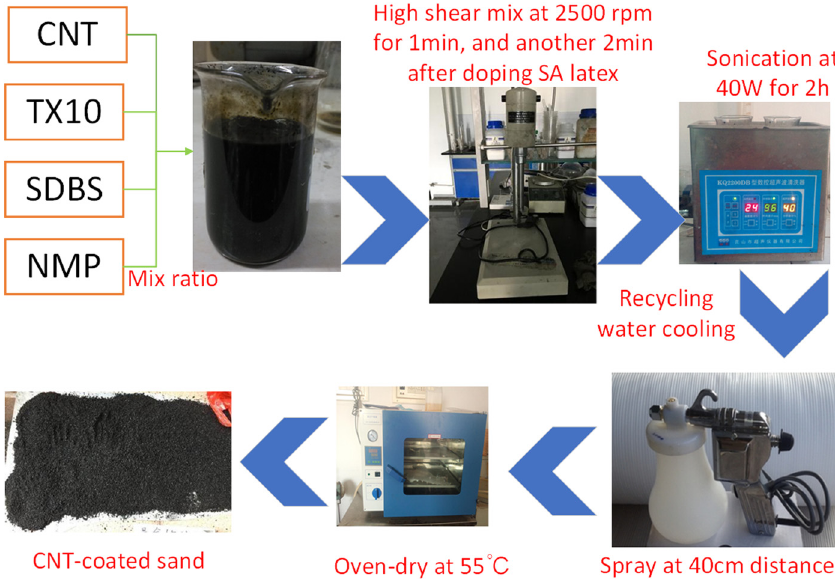
Figure 1: The schematic procedure of MCNT coating onto